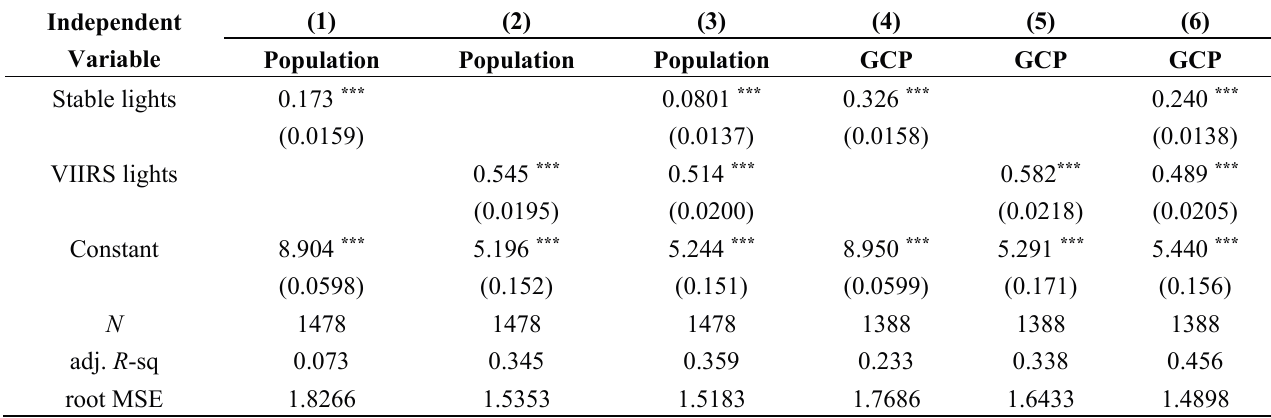
Table 9. Operational Linescan System (OLS) regression for cells with population less